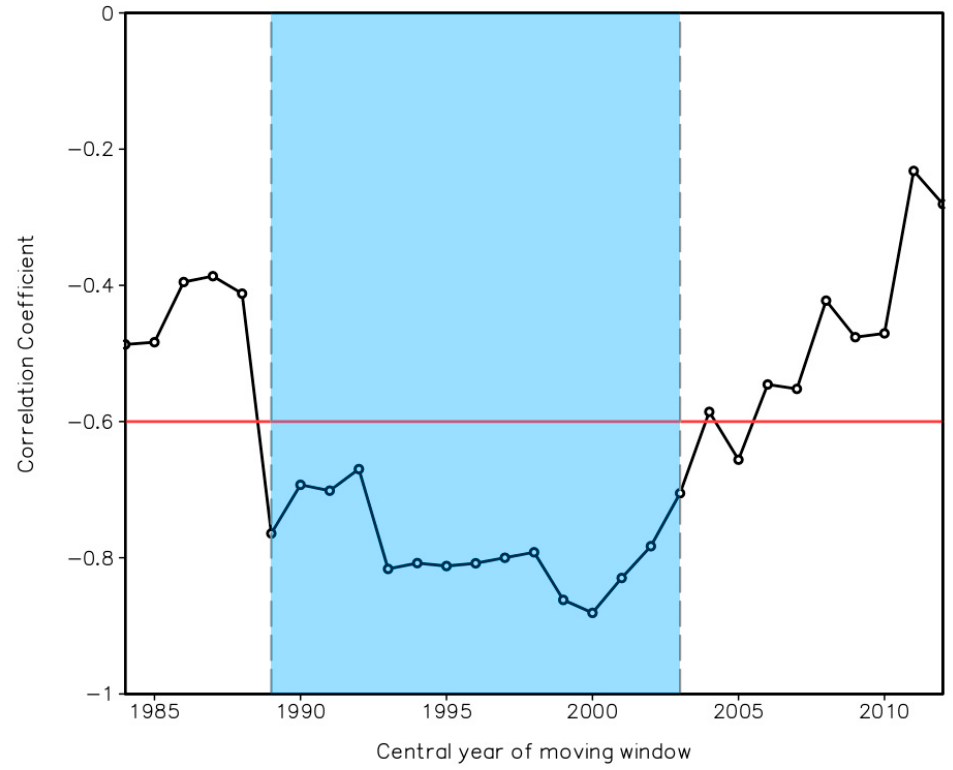
Figure 4. Eleven-year sliding correlation of the NHMCI and SHMCI during 1979–2017, where the red horizontal line denotes the 95% confidence level for the correlation coefficient. The blue region denotes the correlation coefficients between NHMCI and SHMCI are significant at 95% confidence level.